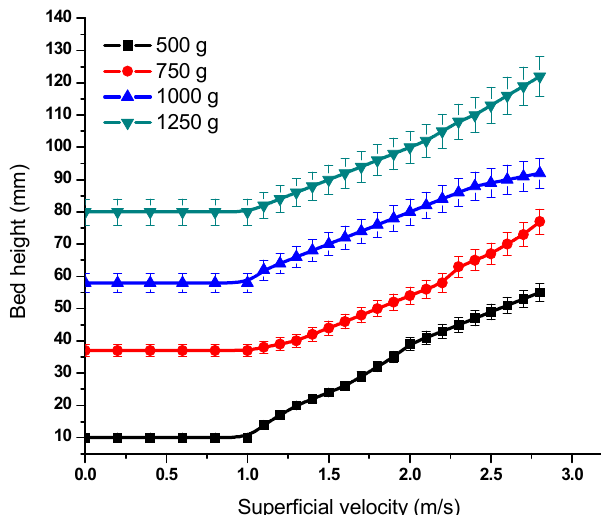
Figure 11. Bed height versus superficial velocity for different bed weights.